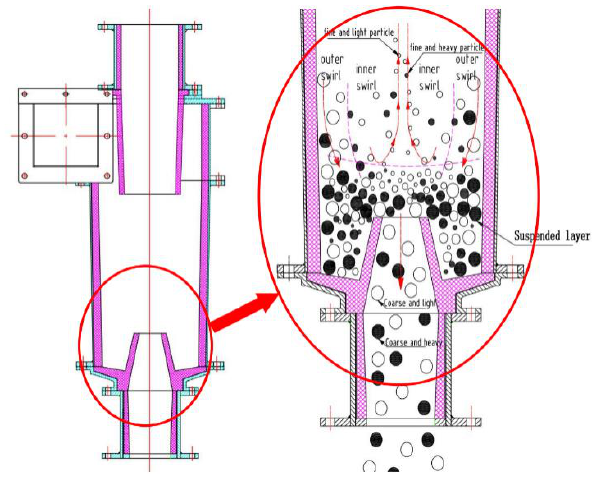
Figure 1. W-shaped full cylindrical hydrocyclone.